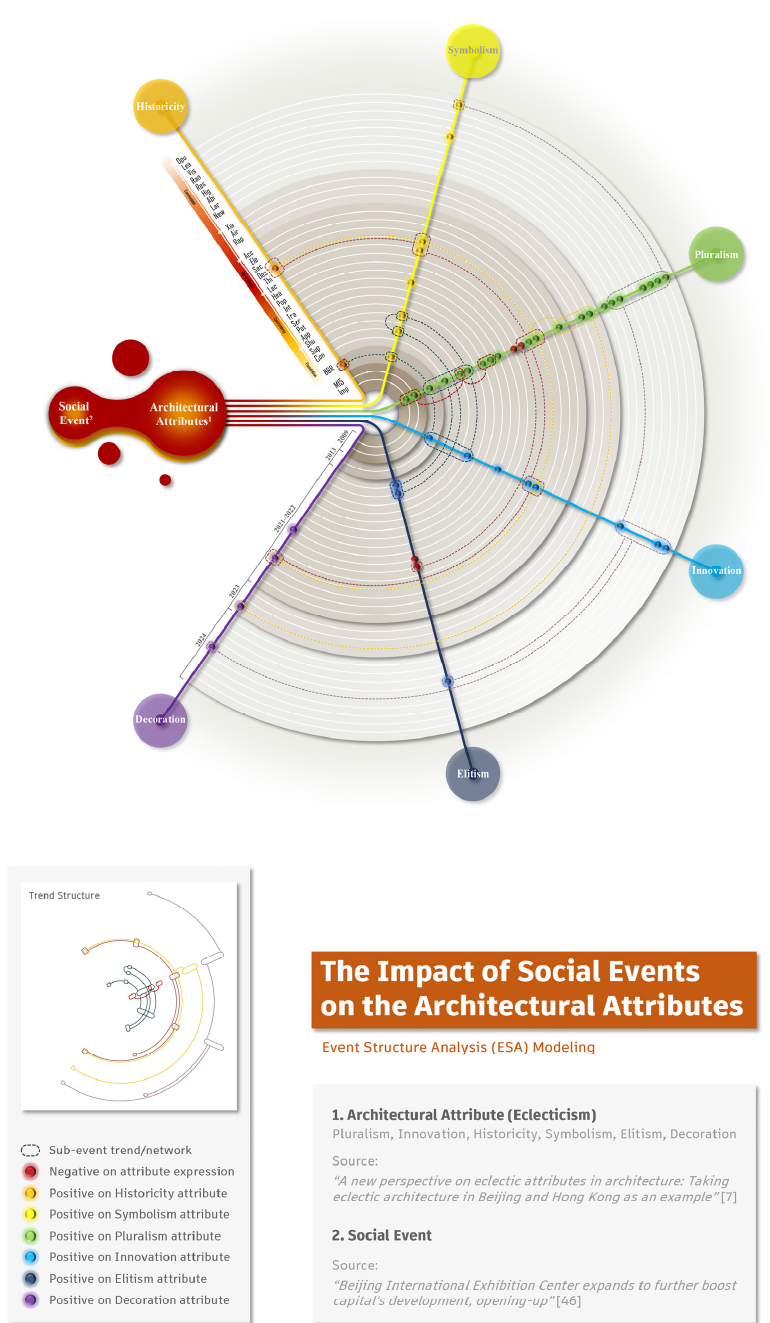
Figure 5. The event-attribute expression impact model.